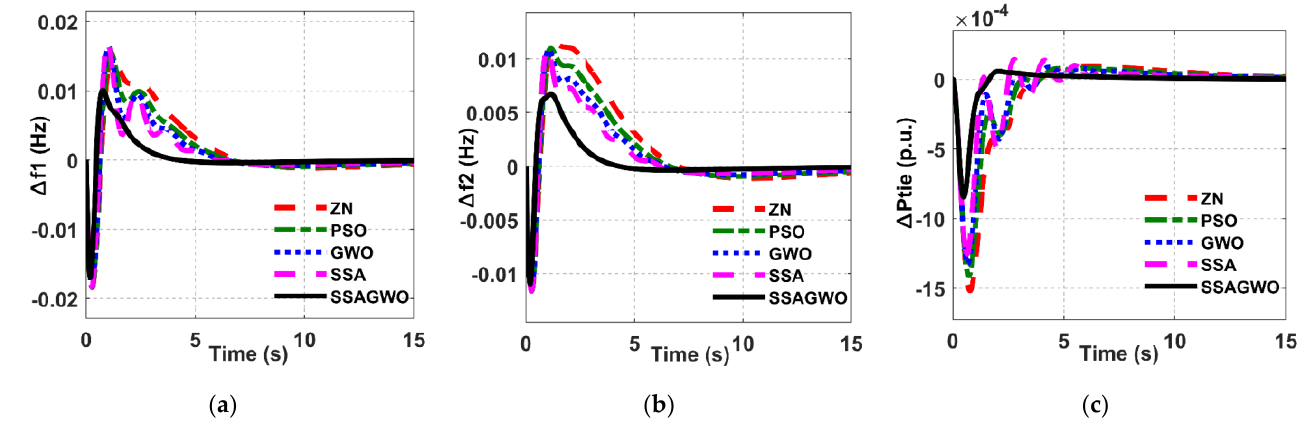
Figure 9. The frequency deviation responses of the optimization techniques and conventional Ziegler–Nichols method for tuning PID controller parameters for case II: ( a ) The frequency deviation of area 1; ( b ) The frequency deviation of area 2; ( c ) The power deviation of the tie line. Table 6. Frequency and power deviation in the tie-line power of case II.